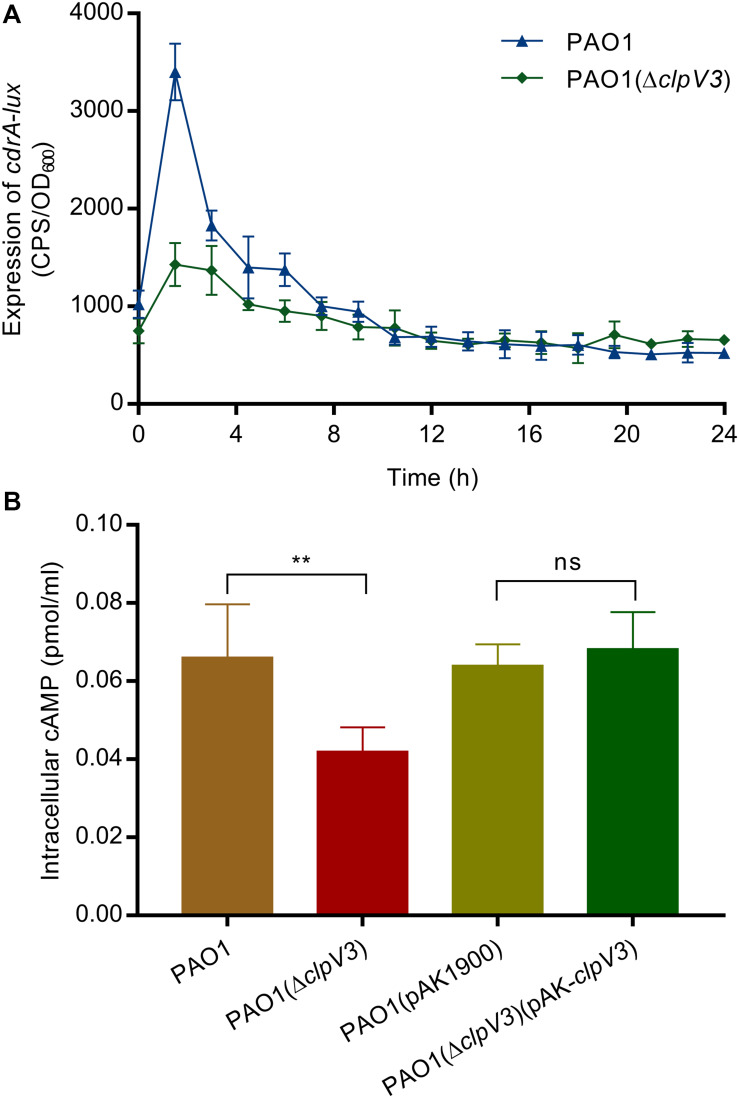
Intracellular concentration of secondary messengers (c-di-GMP and cAMP) were significantly reduced when clpV3 gene was deleted. (A) PAO1(ΔclpV3) exhibited decreased cdrA promoter activity when compared with that of the wild-type PAO1, indicating a clear effect of H3-T6SS on intracellular c-di-GMP levels. (B) cAMP concentration was quantified in wild-type PAO1, PAO1(ΔclpV3) mutant and its complimented strain by using the Cyclic AMP Select ELISA Kit. Lower expressed cAMP was detected in clpV3 deletion mutant compared with either the wild type or its complemented strain. Unpaired Student’s t-test was used to analyze the data, and the means and standard deviations are shown. **p < 0.01, ns, not significant.